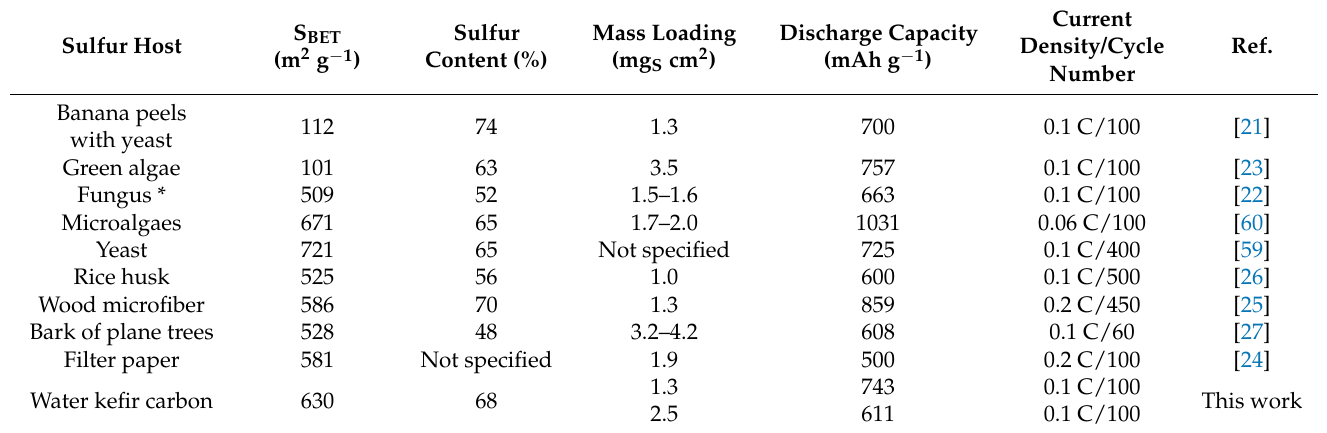
Table 3. Comparison of carbon materials derived from micro-organisms for Li-S batteries found in the